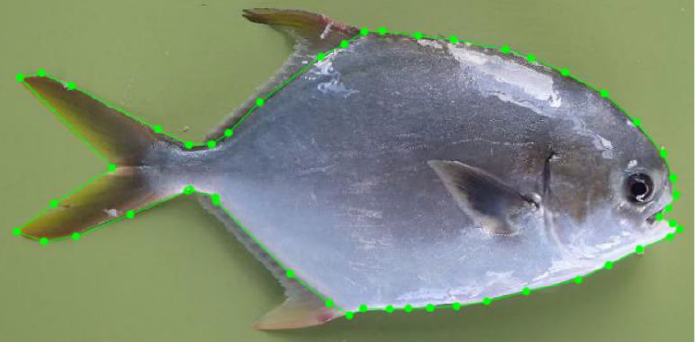
Figure 12. Measurement standard of fish Fig. 7 Measurement standard of fish body area. Fig. 7 Measurement standard of fish body area.